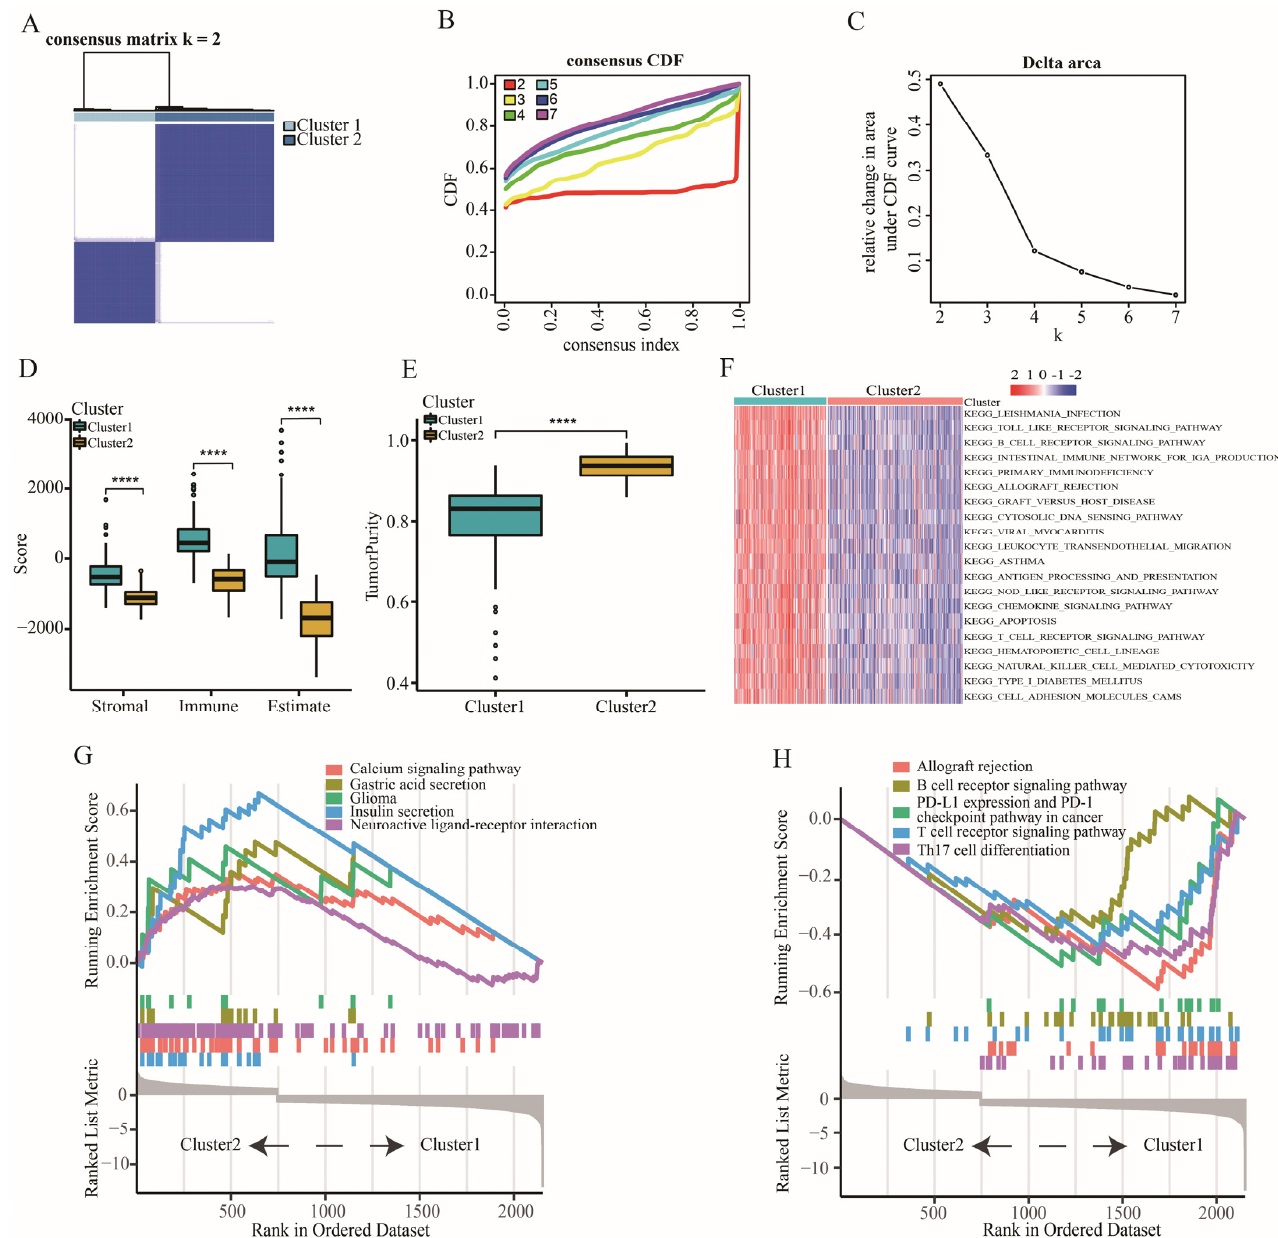
Figure 1. The classification and characteristic of immune subtypes. ( A – C ) Identification of two im- mune subtypes using consensus clustering analysis. ( D ) The expression of stromal, immune, and estimate scores between cluster 1 and cluster 2. ( E ) The difference of tumor purity between cluster 1 and cluster 2. ( F ) GSVA analysis of biological pathways between cluster 1 and cluster 2. ( G )